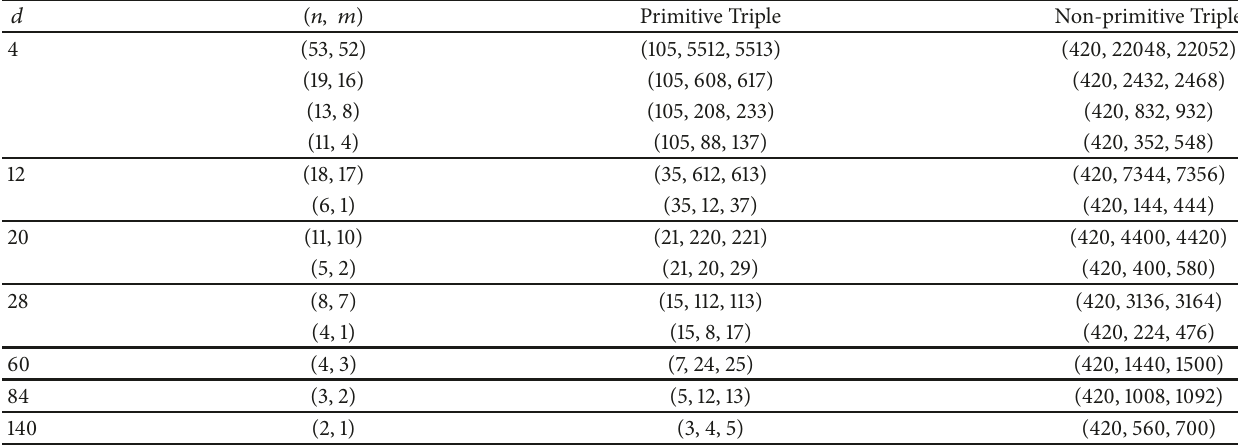
Table 7: Nonprimitive Pythagorean triples with common leg 𝑎 = 420 for each even value of 𝑑